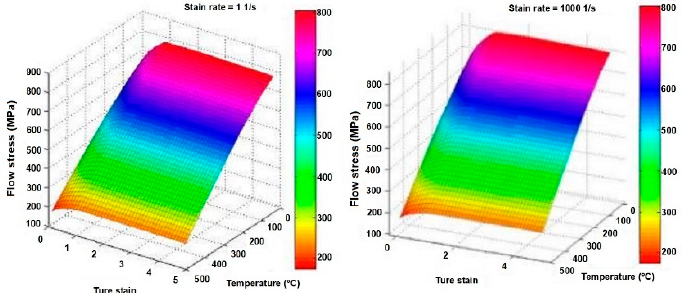
Figure 3. Flow stress curve for the 7075-t6 aluminum alloy.